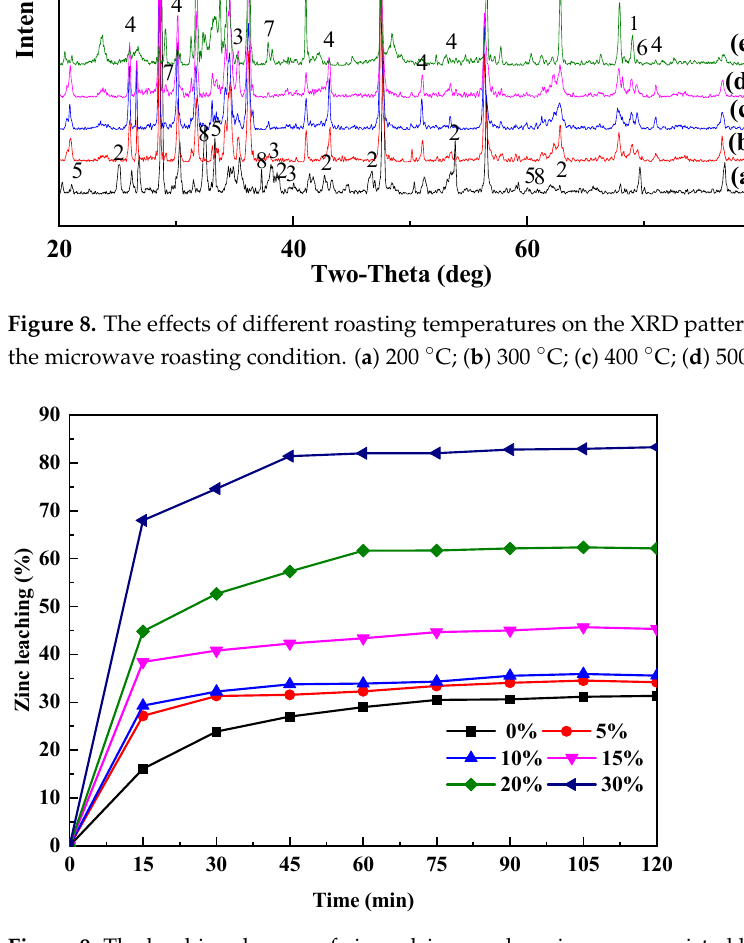
Figure 9. The leaching degrees of zinc calcines under microwave-assisted heating